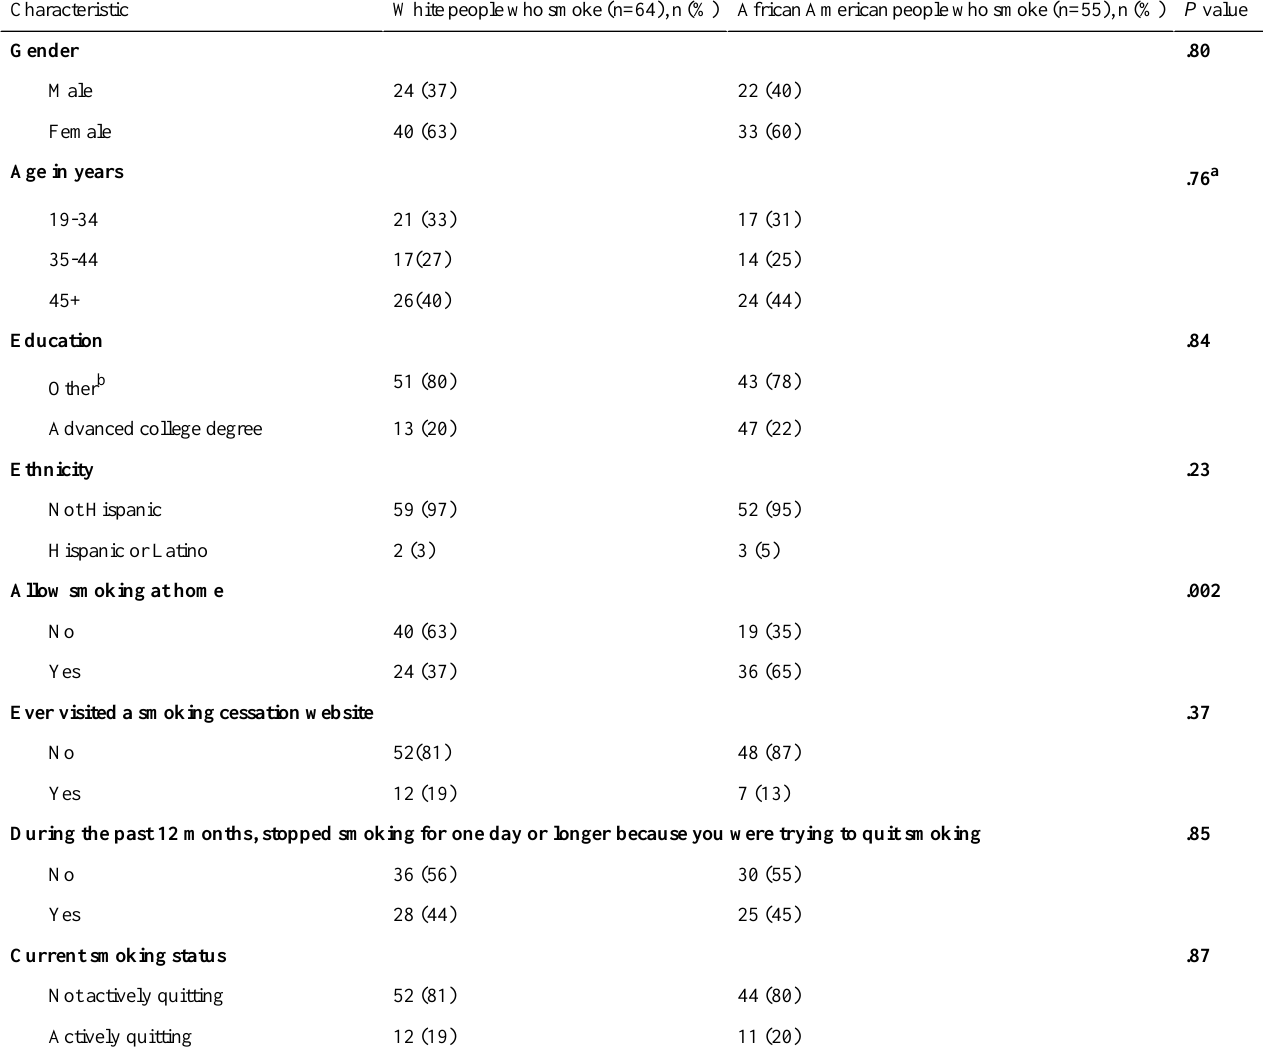
Table 1. Demographic characteristics and smoking behavior at